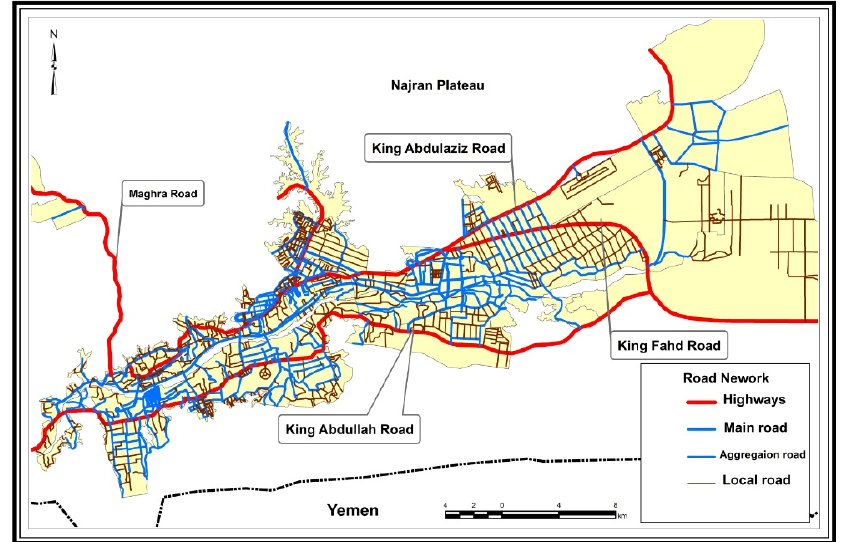
Figure 4. The road and highway networks in